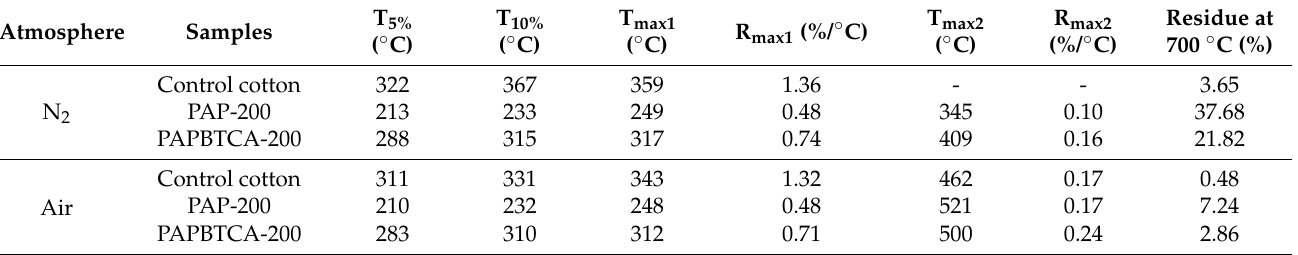
Table 2. Thermogravimetric analysis data of the control, PAP-200, and PAPBTCA-200 in N 2 and